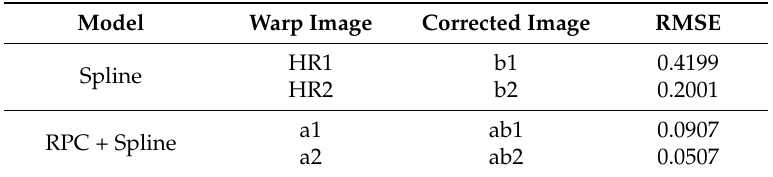
Table 2. The RMSEs of GCPs for rectified images b1/ab1, b2/ab2 (unit: meter). Model